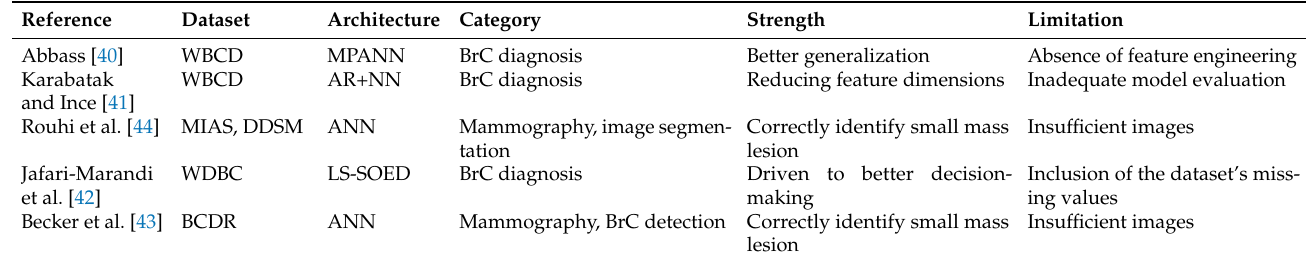
Table 2. State-of-the-art studies based on ANN